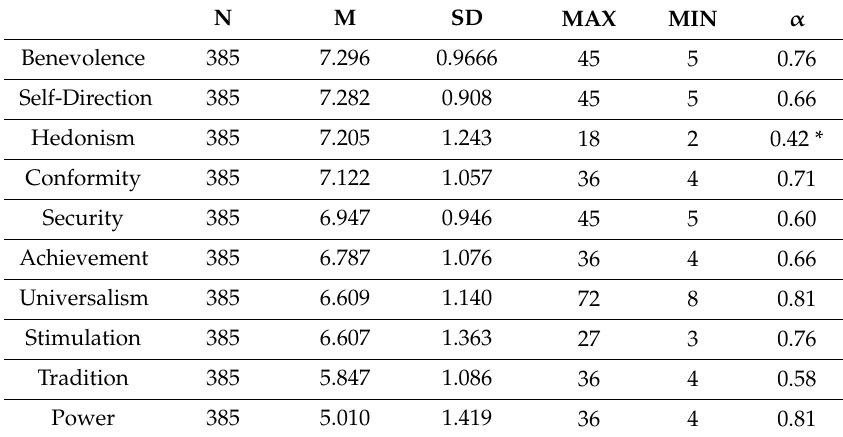
Table 1. Preferred